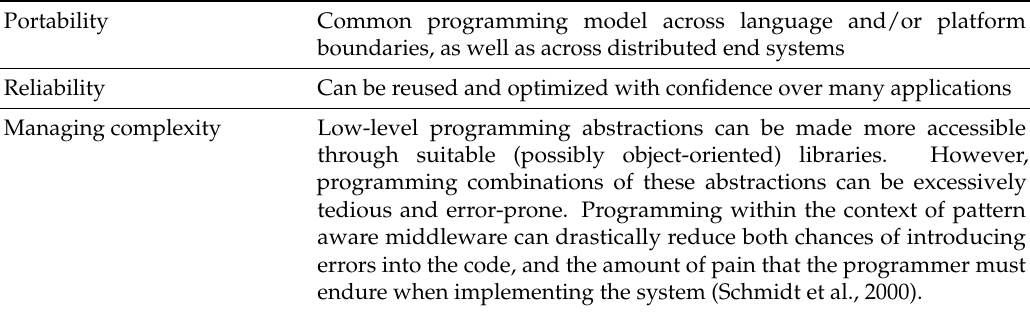
Table 2. Middleware advantage